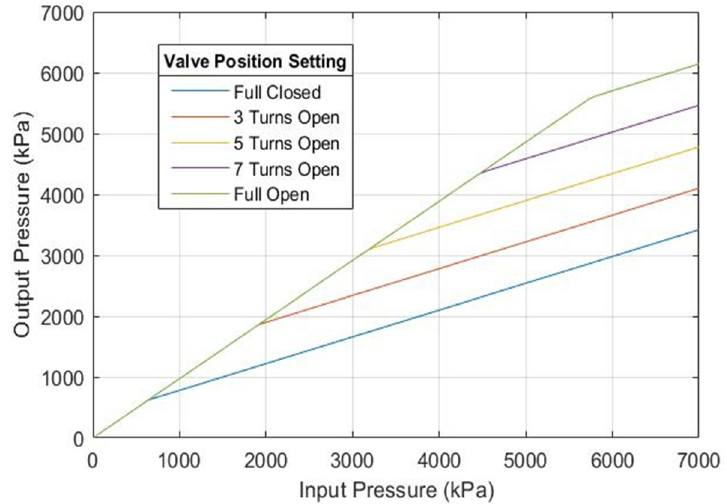
Figure 10. Graph showing the mathematical model of the proportioning valve used in the simulation model.